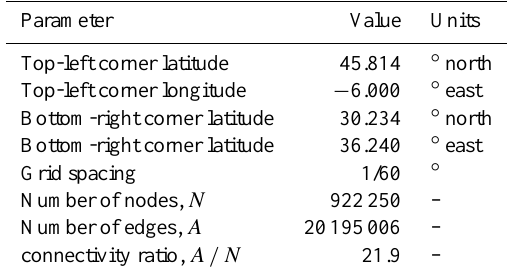
Figure 1. Graph spatial grid. Outgoing edges from the central node are displayed as arrows pointing to the respective tail node. Just the six edges relative to the first quadrant are shown (24-connectivity). The value of the angle θ 12 is provided by Eq. (7).